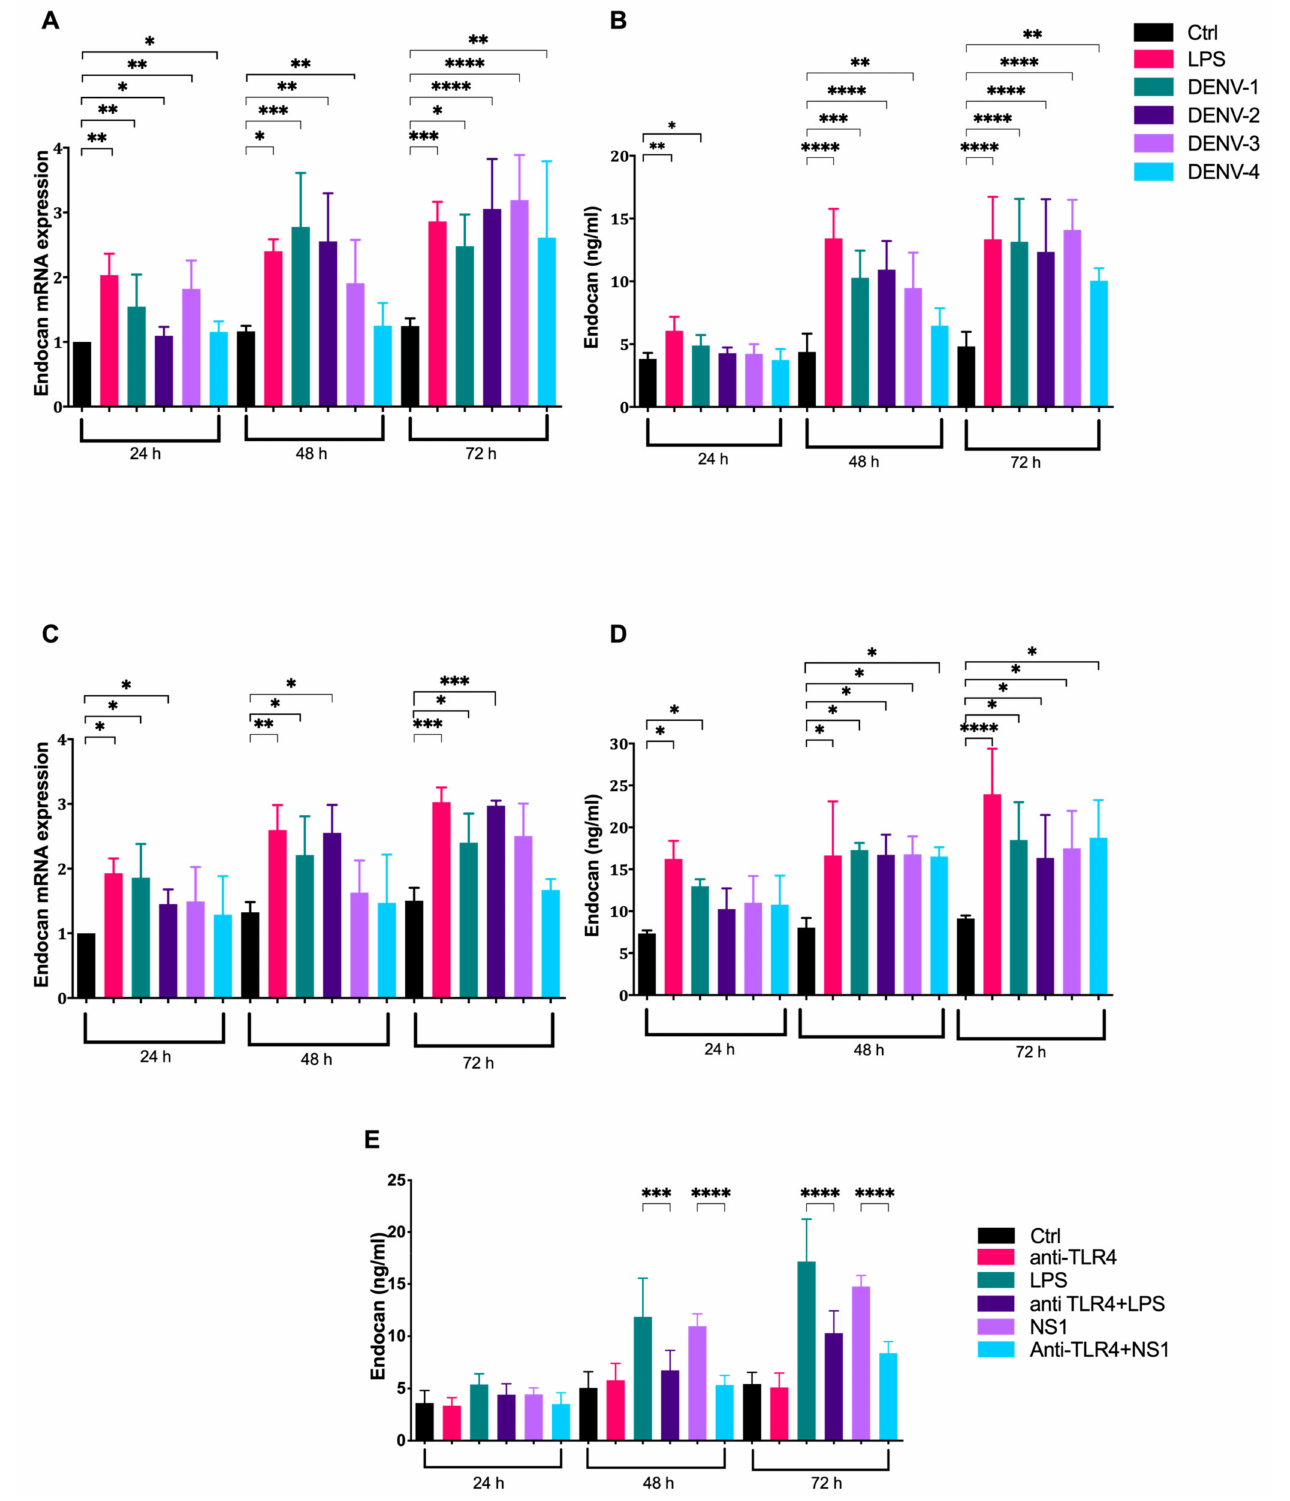
Figure 1. Kinetics of endocan expression and the release induced by NS1 proteins. HMEC ( A , B ) and Human umbilical vein cell line, EA.hy926 (HUVEC). ( C , D ) Cells were cultured with NS1 derived from the four serotypes (5 µ g/mL) for the indicated period and the mRNA expression and serum levels of endocan were then evaluated. HMEC endothelial cells were stimulated with NS1 derived from dengue virus serotype 2 (5 µ g/mL), with or without preincubation with the TLR-4 antagonist antibody (5 µ g/mL), and the serum endocan levels were then measured ( E ). Experiments were performed in triplicate and repeated three times with similar results. * p < 0.05, ** p < 0.01, *** p < 0.001, **** p <